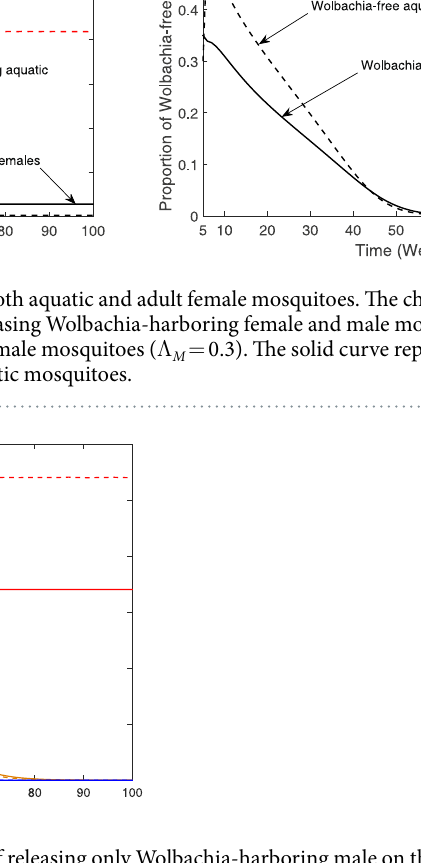
Figure 7. The effect of the strength Λ M of releasing only Wolbachia-harboring male on the size of Wolbachia- free population. The solid curve represents adult mosquitoes and the dashed curve represents aquatic